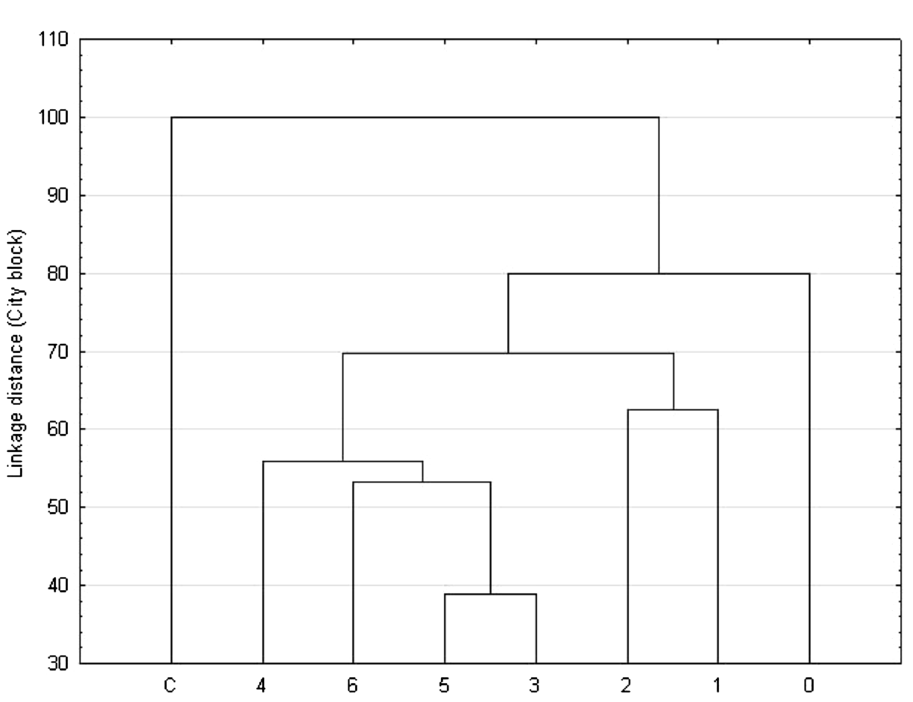
Figure 5. Dendrogram of cluster analysis (WPGMA) showing the similarities of foliage samples based on the chemical composition. C = park trees (control, n = 25), 0–6 = roadside trees (n = 50 per leaf damage